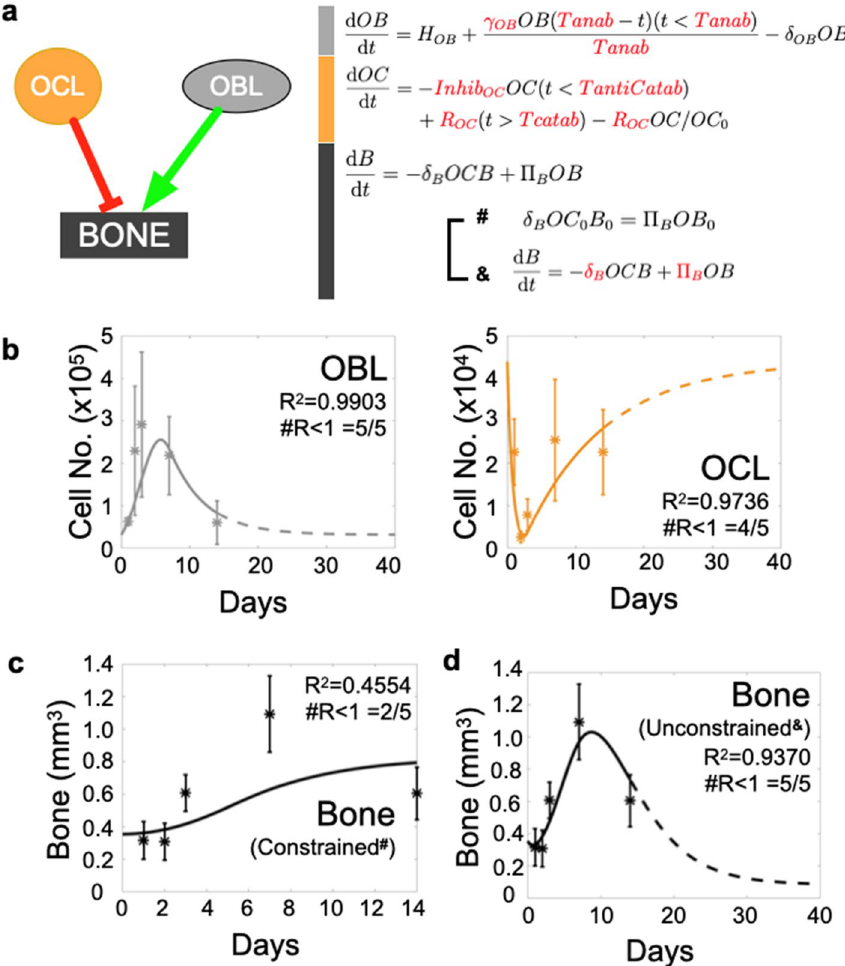
Figure 2. Osteoblast (OBL) and osteoclast (OCL) activities as measured at homeostasis do not allow accurate bone prediction during injury repair in vivo. Histological quantitation of tibia bones parameterizes mathematical ordinary differential equation (ODE) model of bone injury repair. ( a ) Ordinary differential equations (ODE) describing dynamics of OCL and OBL population are paired with published parameters to form an initial ODE model to predict bone repair dynamic. Schematic depicts OCL resorb (red line) and OBL form bone (green line). ODE expressions with unknown value (red) were estimated as the model optimizes fits to in vivo data. ( b ) Model produces accurate fits to OCL and OBL dynamics. ( c ) Model falsely predicts bone dynamics given OBL and OCL fits in the first 14 days following bone injury when it samples various publication-derived OCL resorption rates (each dashed line represents one sampling). OBL bone formation rates are mathematically estimated in each sampling to ensure predictions will eventually return to homeostasis ( # ). ( d ) Alternatively, ODE model was allowed to freely seek out a combination of resorption and formation rates to best fit data within the 14-day time period ( &